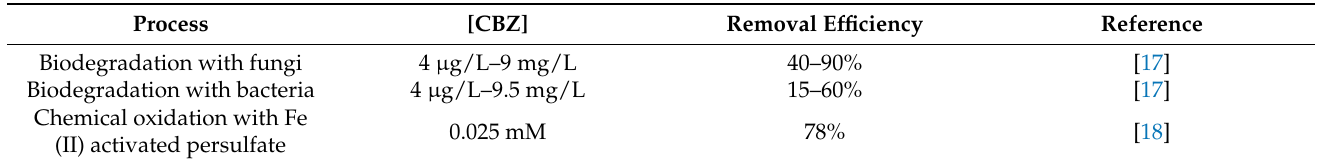
Table 1. CBZ efficiency removal via conventional